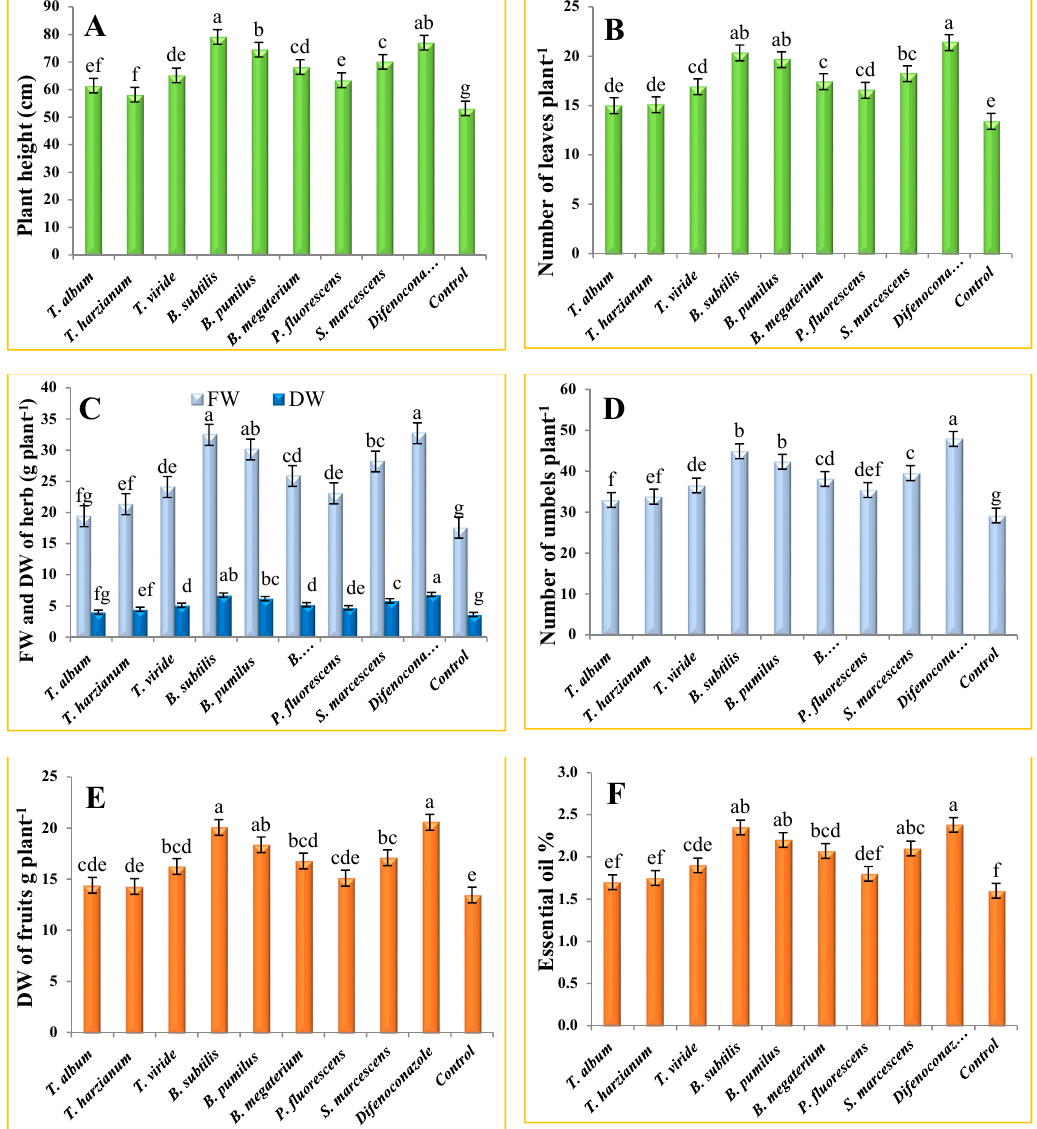
Figure 1. Effect of biocontrol agents and synthetic fungicide on ( A ) plant height; ( B ) number of leaves/plant; ( C ) fresh {FW} and dry weight {DW} of herb per plant; ( D ) number of umbels per plant; ( E ) dry weight of fruits per plant and ( F ) essential oil content of celery crop. Data are mean of two repeated trials during the growing seasons 2018/2019 and 2019/2020, each with three replicates. Different letters (a, b, c, etc.) on the columns show significant differences between the treatments according to Duncan’s multiple ranges test at 0.05 statistical level, ± bars indicate to standard errors of the